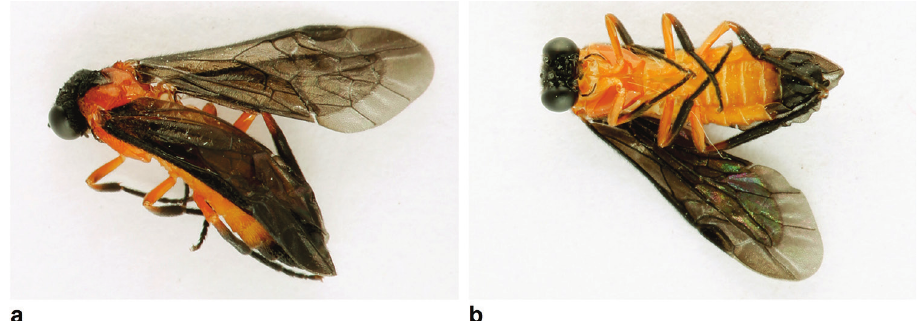
Figure 17. Bolivius sp., male (P4215.C), body length 6.0 mm. a Dorsal view b ventral view.